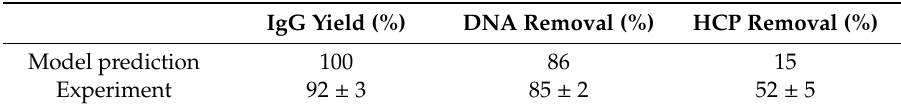
Table 4. IgG yield and removal of process related impurities of the optimized ATPS (ATPS Opt) in LP. IgG: immunoglobulin type G. ATPS: aqueous two-phase system. LP: light phase.